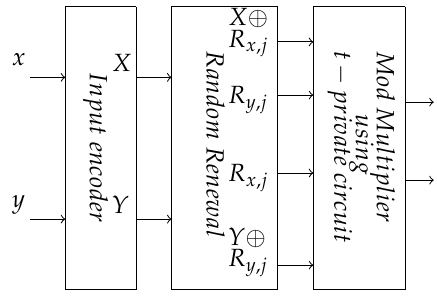
Figure 7. Secure RNS circuit with t -private